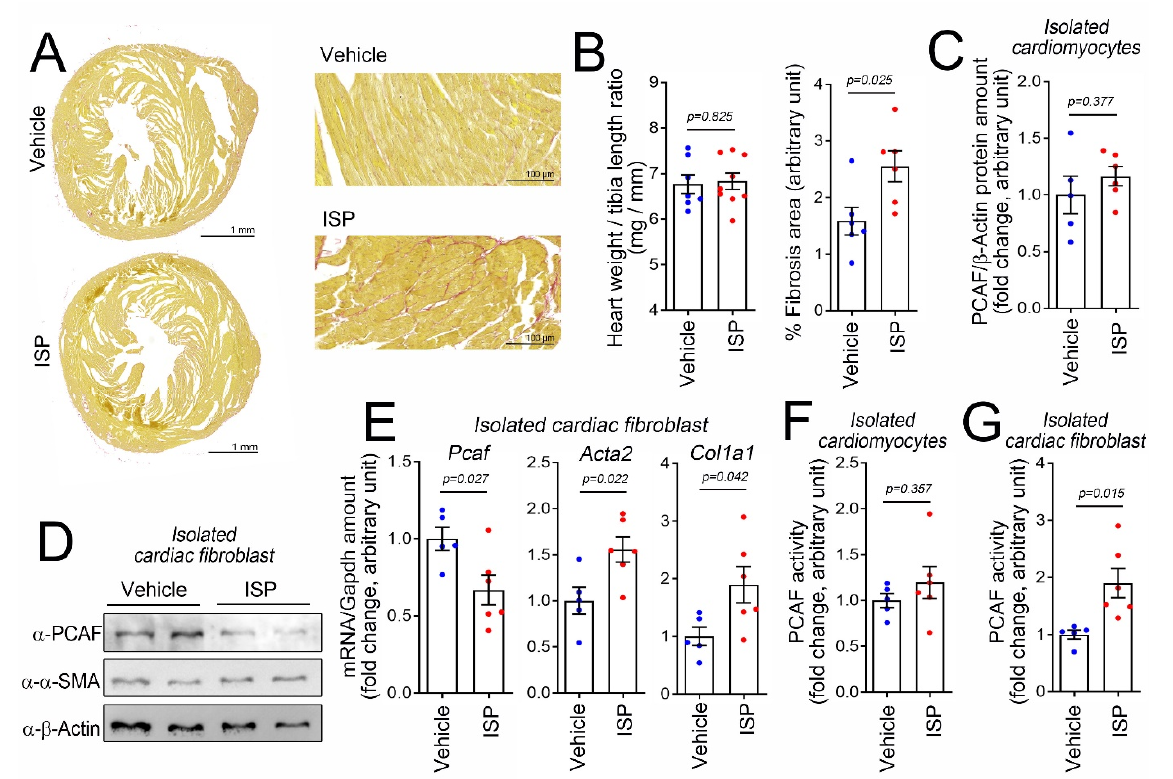
Figure 1. Intraperitoneal (i.p.) administration of high-dose isoproterenol (ISP) induced cardiac fibrotic stress and activates the p300/CBP-associated factor (PCAF) in cardiac fibroblasts in mice. ( A ) ISP (160 mg/kg, i.p.) injection caused fibrosis. Picrosirius red staining is shown. The mouse hearts were harvested 6 days after injection. Higher magnification images are provided in the panels on the right. ( B ) High-dose ISP did not induce enlargement of the heart but did increase the fibrosis area. ( C ) ISP did not alter the protein amount of the PCAF in the isolated cardiomyocytes obtained from the mouse heart. ( D ) ISP decreased the protein amounts of the PCAF in cardiac fibroblasts isolated from the mouse heart. α-SMA, a fibrosis marker protein, was slightly increased by ISP. ( E ) Changes in mRNA levels determined by quantitative RT-PCR. ( F ) PCAF acetylase activity in the isolated cardiomyocytes was not altered by ISP. ( G ) PCAF activity was significantly increased in the isolated cardiac fibroblasts by ISP. Each dot in the bar graphs shows the value of one case. Data are shown as mean ± standard error of the mean (SEM). p -values for the different comparisons are shown in the figure.